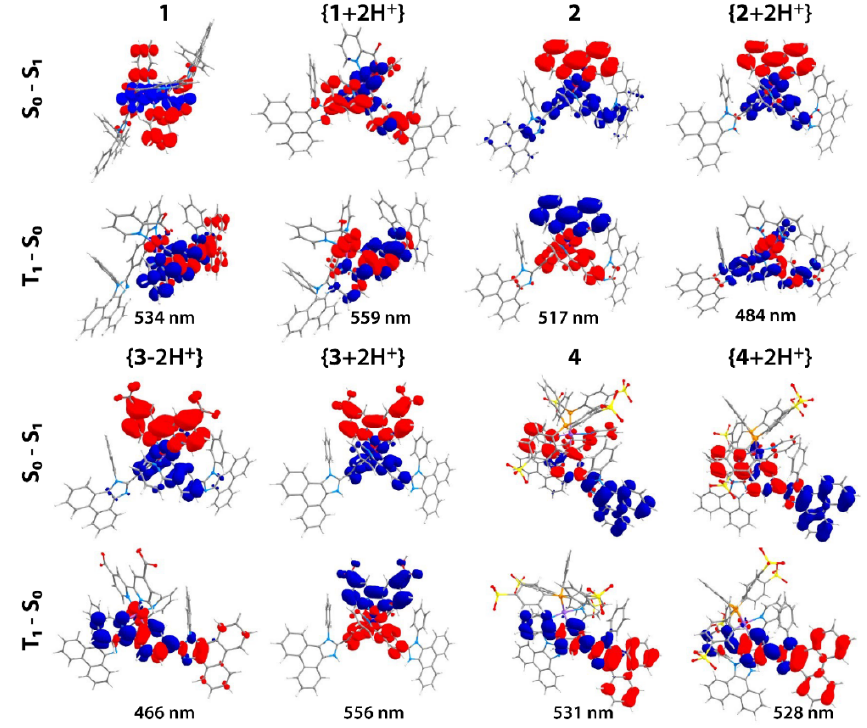
Figure 6. The decrease (blue) and increase (red) in electron density for S 0 → S 1 and T 1 → S 0 electronic transitions for complexes 1 – 4 , and calculated emission wavelengths. Note that { 3 − 2H + } is the anion formed by the dissociation of two protons from the ligand carboxylic functions.